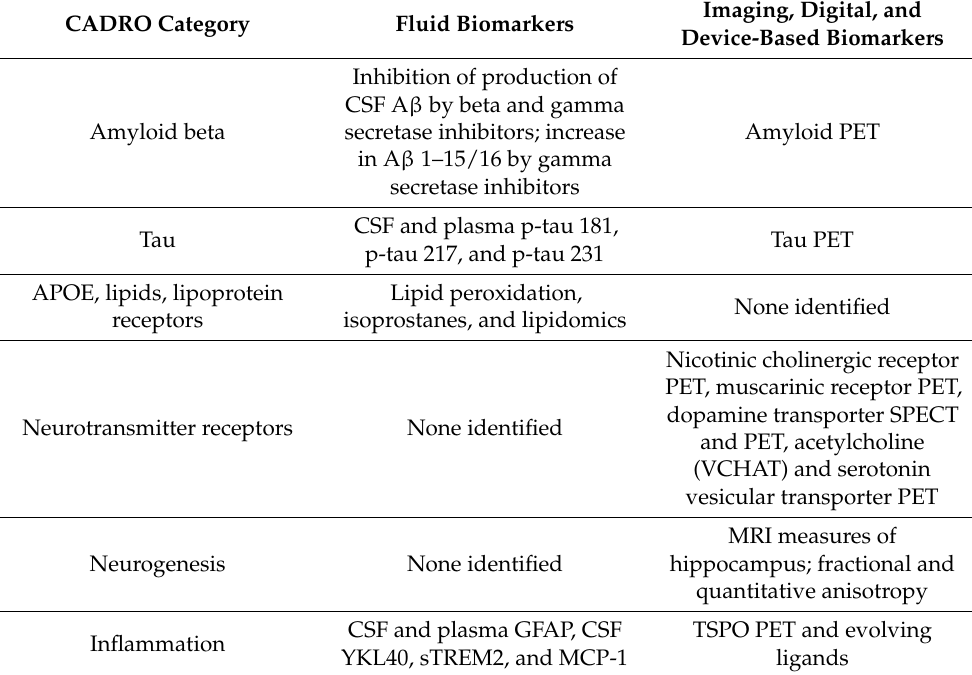
Table 2. Target engagement biomarkers (CADRO—Common Alzheimer’s Disease Research Ontol- ogy); target engagement biomarkers are typically proximal in the cascade of events leading to cell death and dementia in AD. Biomarkers used to demonstrate disease modification using the amyloid, tau, neurodegeneration (A,T(N)) approach are listed in Table 3. Both well-established biomarkers and emerging, partially validated biomarkers are included in the table (the table is not an exhaustive list of all emerging